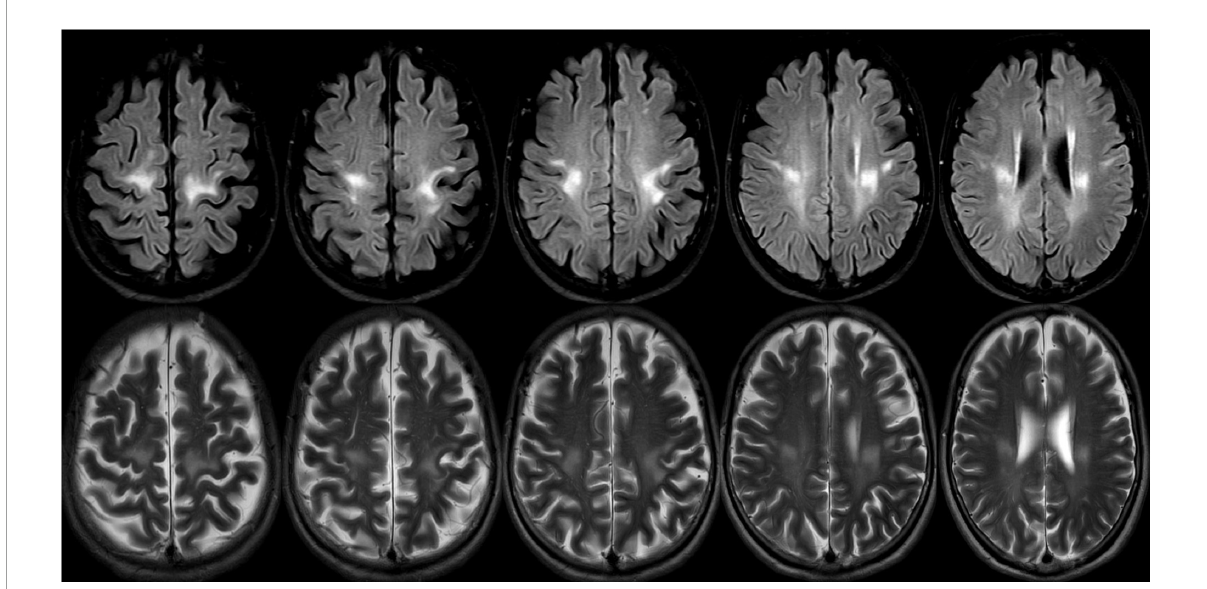
FIGURE5 A 69-years-old female presented with a 2-year history of progressive weakness of the lower limbs. A brain magnetic resonance imaging (MRI) revealed abnormal T2 and flair hyperintensities in the periventricular and deep cerebral white matter, and the bilateral subcortical areas of parietal white matter (the lesions were continuous and symmetrically distributed). Reduced galactocerebrosidase activity and GALC gene confirmed the diagnosis of adult late-onset